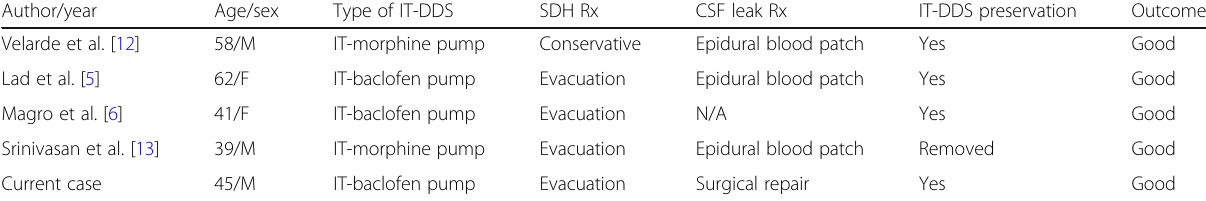
Table 1 Reported cases of subdural hematoma following insertion of an intra-thecal drug delivery system